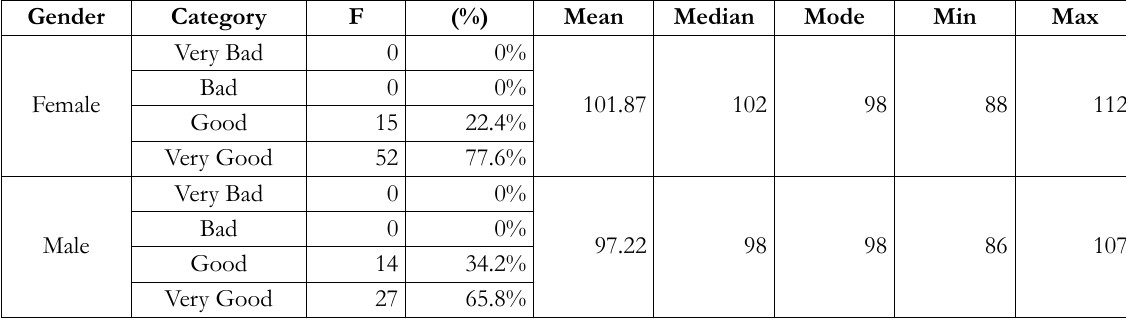
Table 7. Eighth Grade Student’s Perception of the Use of Web-based Character